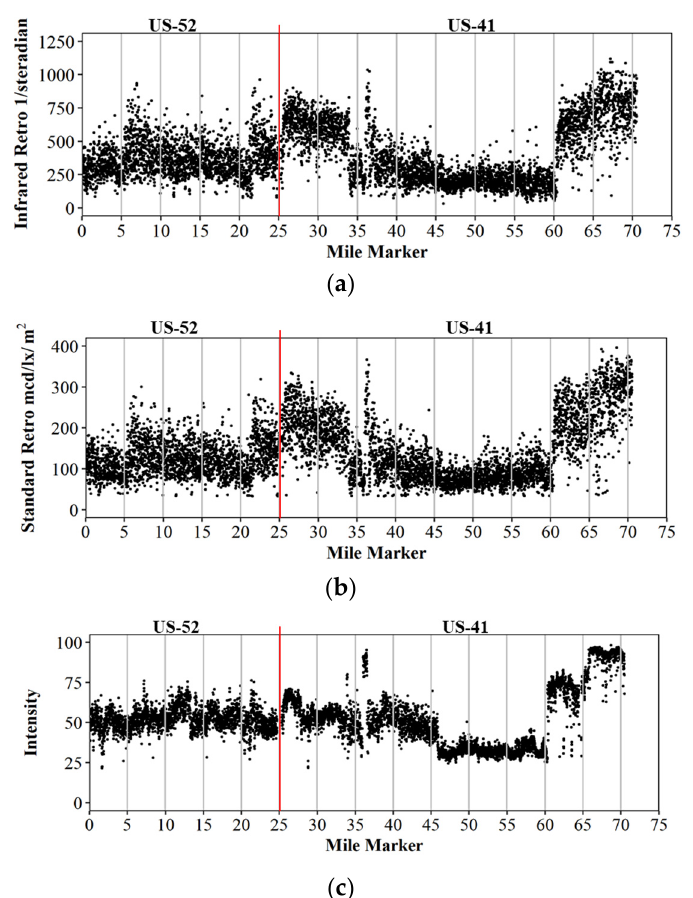
Figure 4. Northbound center skip line retroreflective and LiDAR intensity readings: ( a ) infrared retroreflective values; ( b ) northbound standard retroreflective values; ( c ) LiDAR intensity values.